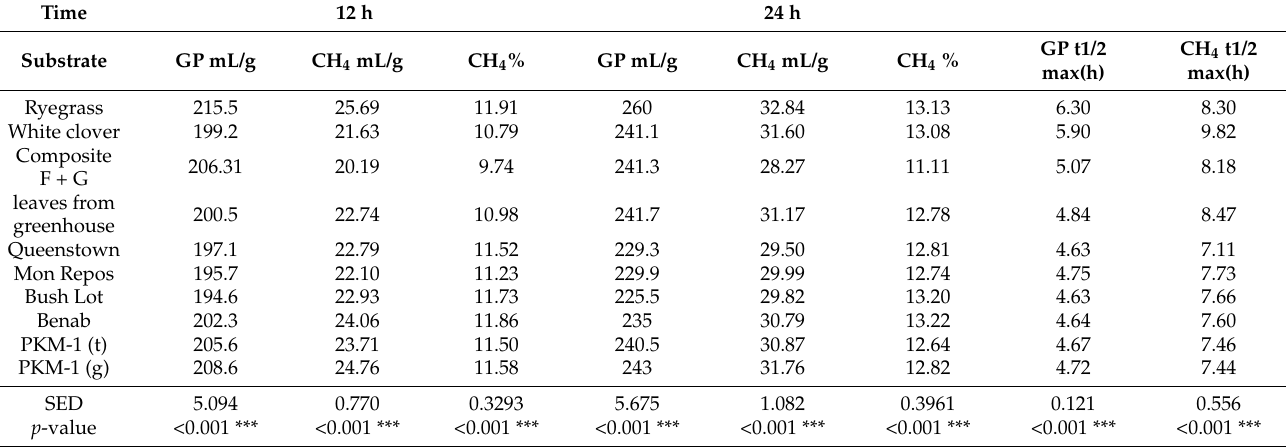
Table 5. Total gas production, methane and proportion of methane at 12 and 24 h for M. oleifera composite sample, young leaves of M. oleifera , Queenstown, Benab, PKM-1 (t), PKM-1 (g), Mon Repos, Bush lot, Ryegrass ( L . perenne ) and white clover ( T . repens ). Gas and methane production rate is shown (GP t 1/2 max and CH 4 t 1/2 max). The average standard error of the differences of means (SED) and p -value are